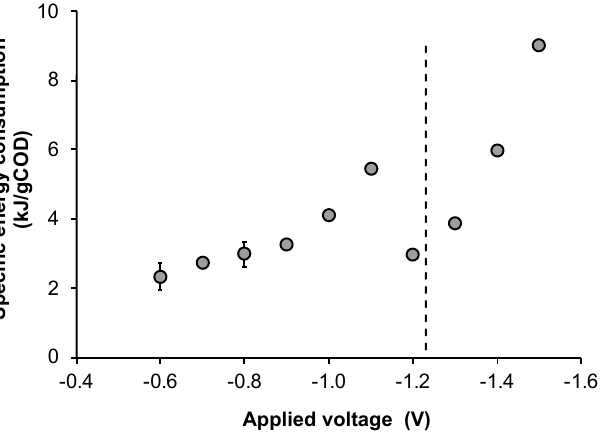
Figure 5. Effect of the applied voltage on the specific energy consumption associated to butyric acid production (error bars represent the standard error of replicated experiments). The dashed line represents the thermodynamic cell voltage for water electrolysis.